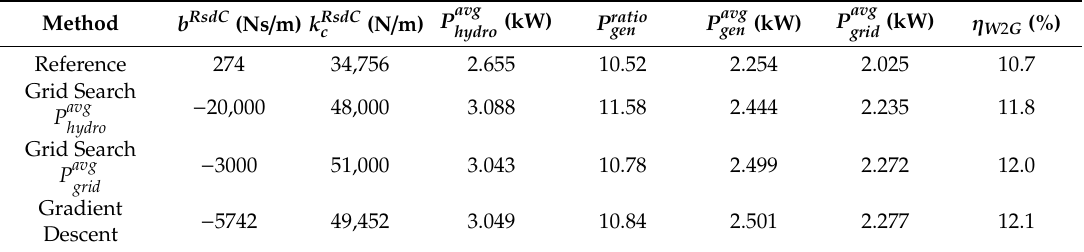
Table 6. Summarized Reactive Spring Damping Controller